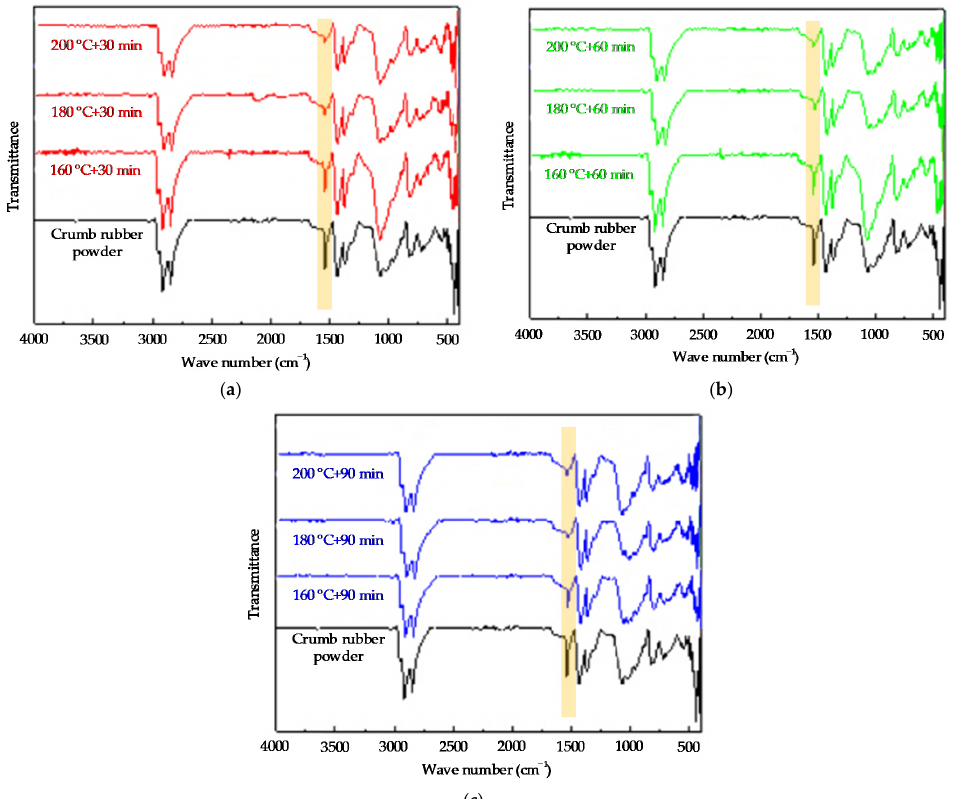
Figure 7. The infrared spectrum of crumb rubber by heat activation treatment at different tempera- tures: ( a ) 30 min; ( b ) 60 min; and ( c ) 90 min. tures: ( a ) 30 min; ( b ) 60 min; and ( c ) 90